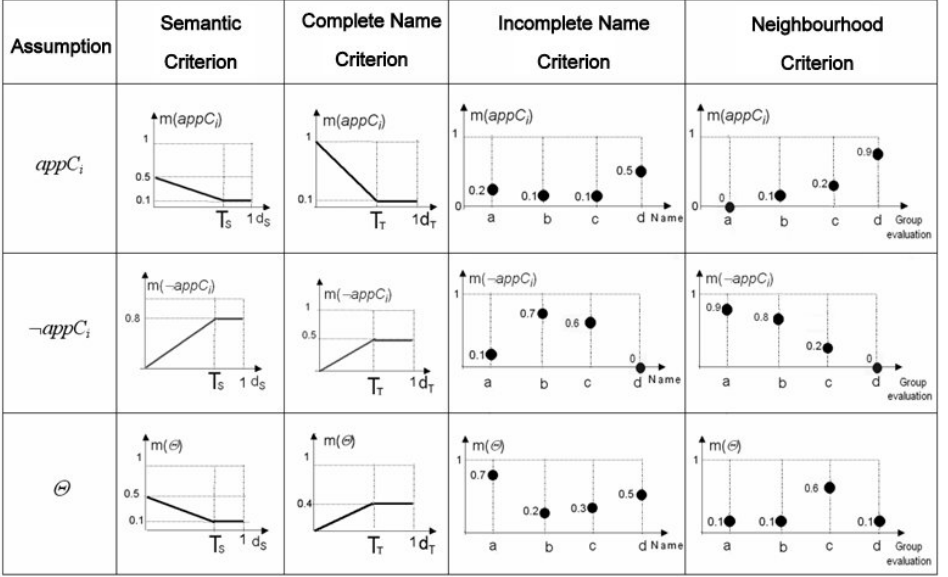
Figure 3: Knowledge modeling for Semantic, Complete Name, Incomplete Name , and Neigh- borhood Criteria